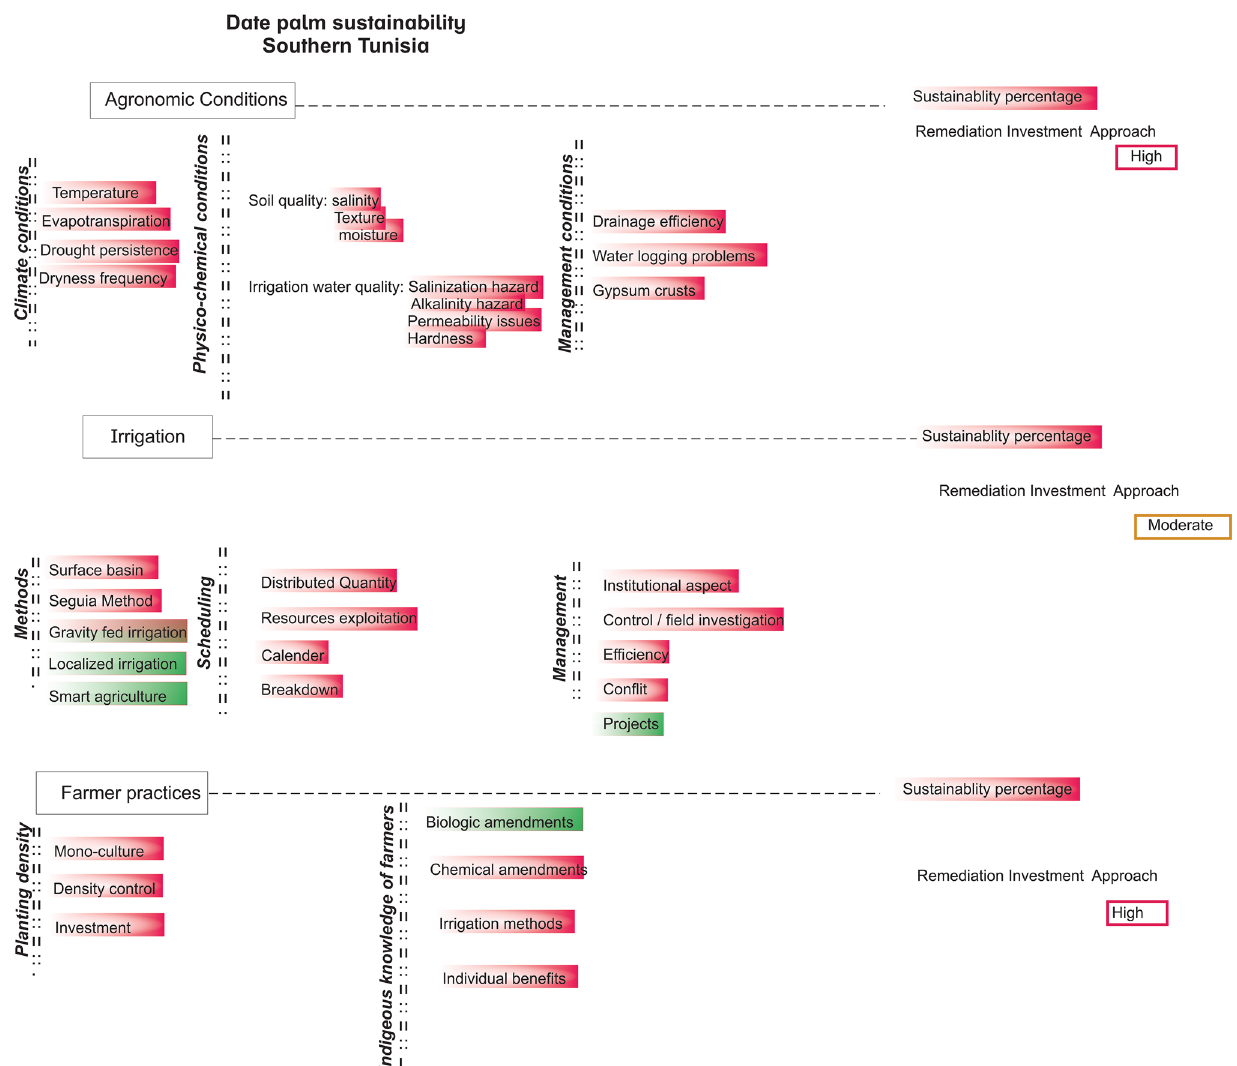
Fig. 12 Synthetic evaluation of factors influencing date palm